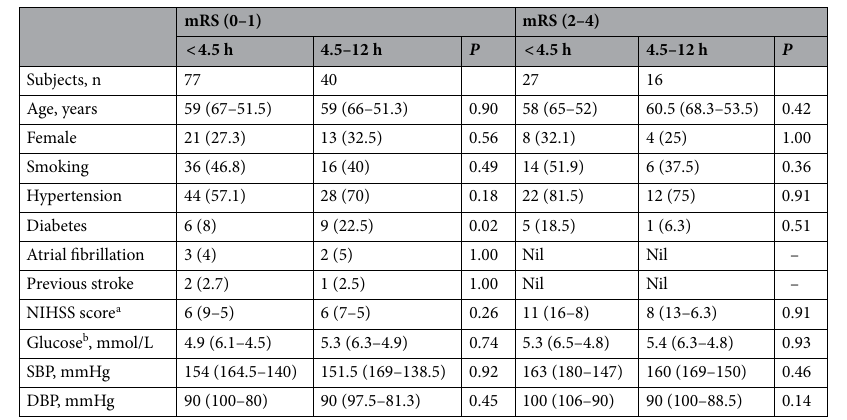
Table 2. Baseline and clinical characteristics of patients stratified by outcomes and subdivided by onset-to- treatment. Reported as n (%) or median (IQR = Q3–Q1), or as indicated. a Baseline. b At admission.